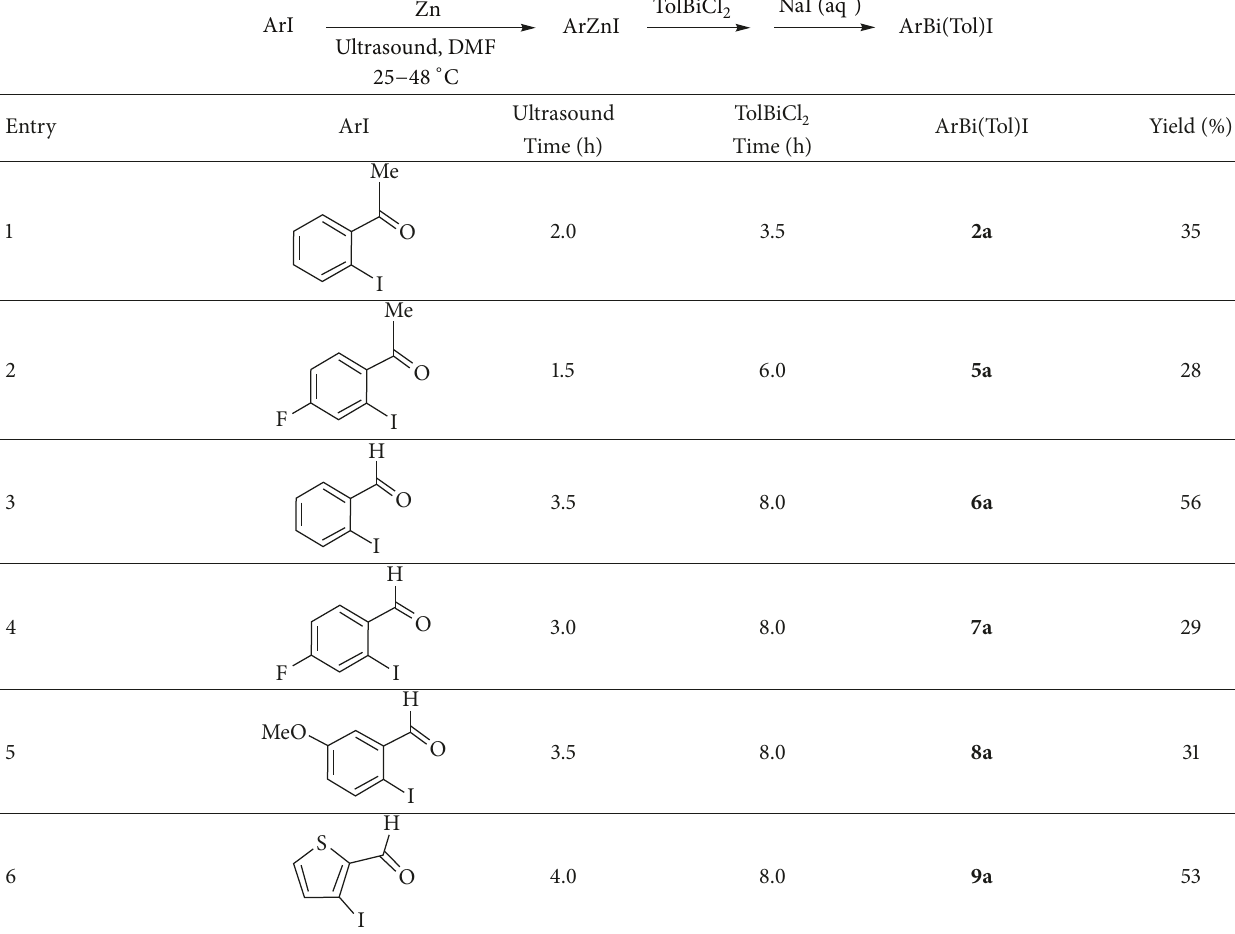
Table 2: Synthesis of